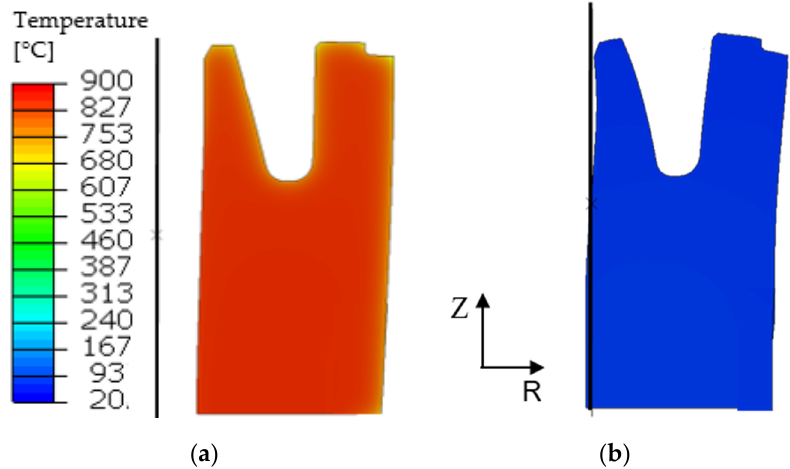
Figure 10. Deformation scale factor: 15. Surface plots in ( a ) austenitized and ( b ) quenched state. The mandrel is a rigid body that does not deform. Figure 8b reveals a gap between the gear blank and the mandrel in the quenched state when in contact.